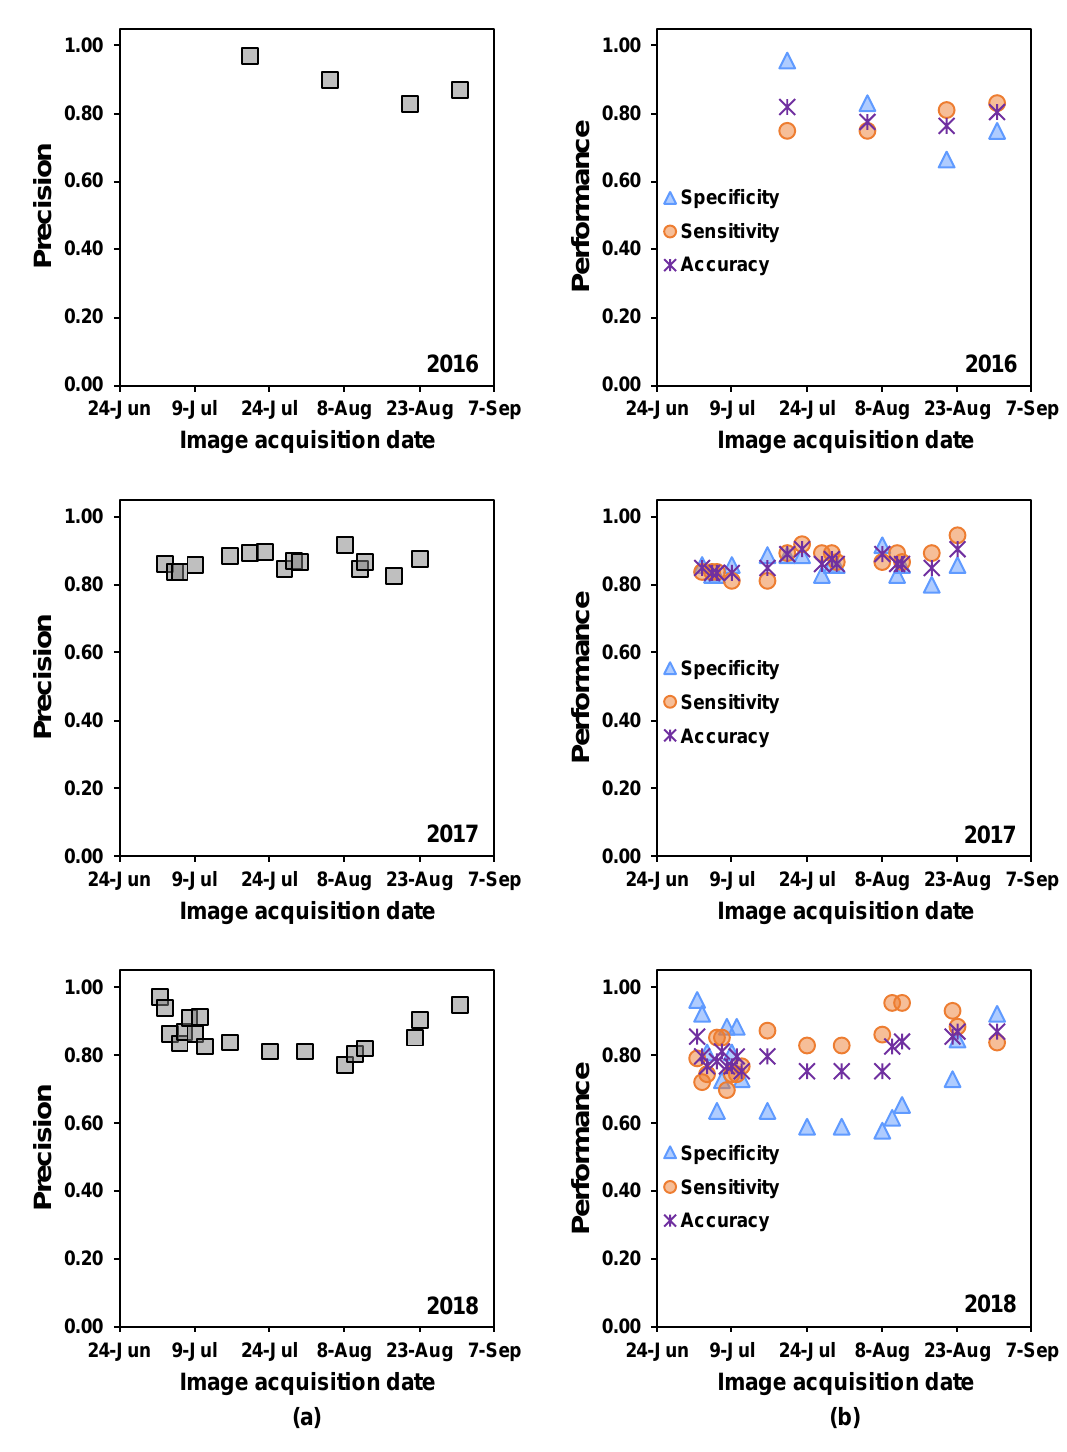
Figure 7. ( a ) Classification precision (proportion of quadrats classified as “diseased” that were assigned correctly), ( b ) specificity (proportion of correctly classified healthy quadrats), sensitivity (proportion of correctly classified diseased quadrats), and accuracy (proportion of observations classified correctly) achieved by random forest trained models for SDS detection in soybean quadrats in 2016 through 2018. In all growing seasons, SDS-infected quadrats were detected with high accuracy, even before the onset of visible foliar symptoms.